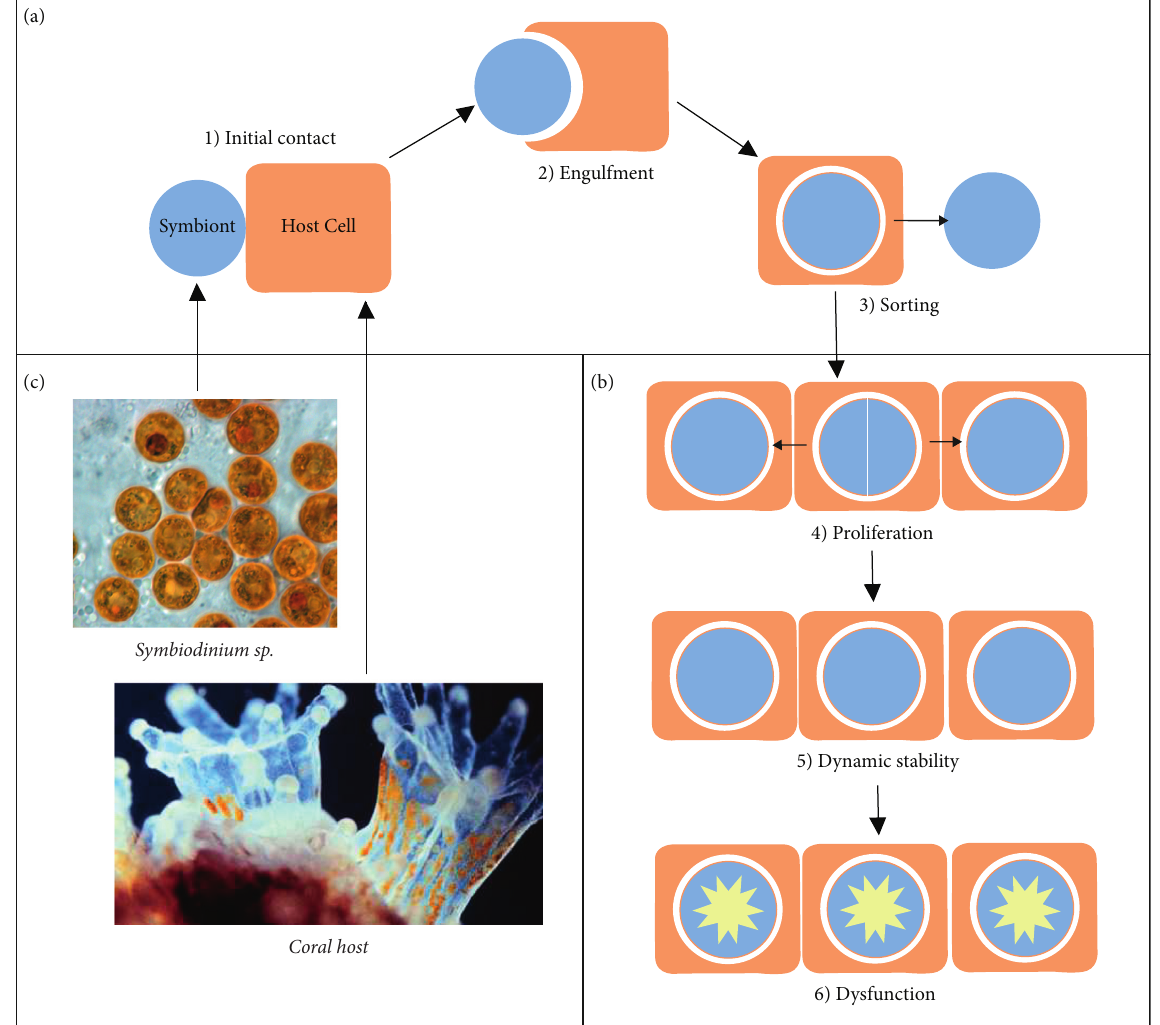
Figure 2: Phases of endosymbiosis establishment and persistence in cnidarian- Symbiodinium interaction (modified from